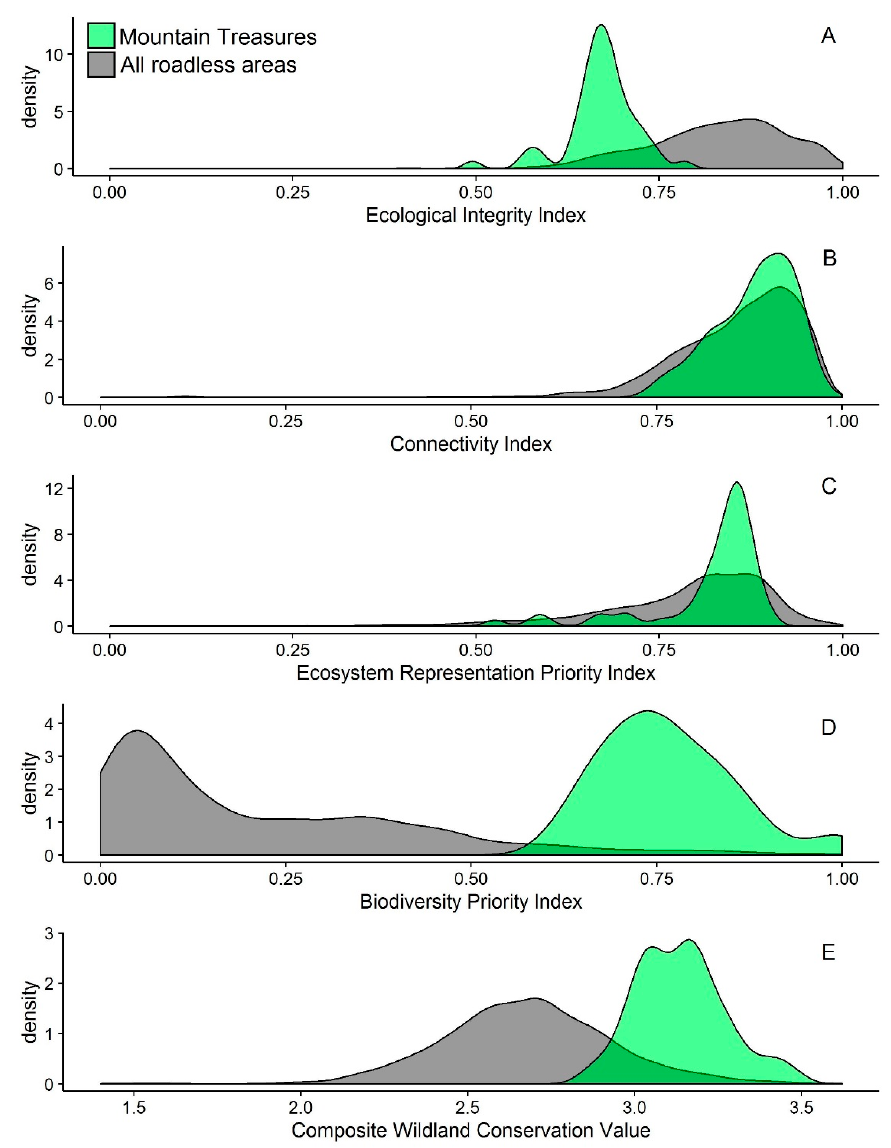
Figure 2. The distribution of conservation priorities for Mountain Treasures (green) and all other roadless areas in the lower 48 United States (grey) based on data from Belote et al. (2017). The values for the top four indices range from 0 (low) to 1 (high) nationally. These indices were combined into a composite Wildland Conservation Value index (bottom panel). ( A ) Ecological integrity; ( B ) Connectivity; ( C ) Ecosystem representation priority; ( D ) Biodiversity priority index; ( E ) Composite wildland conservation value.